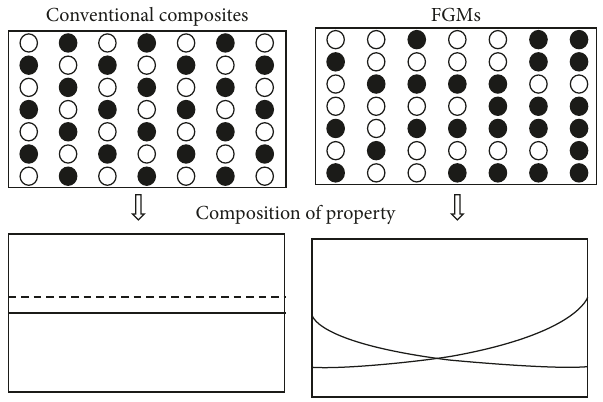
Figure 1: Variation of properties in conventional composites and FGM